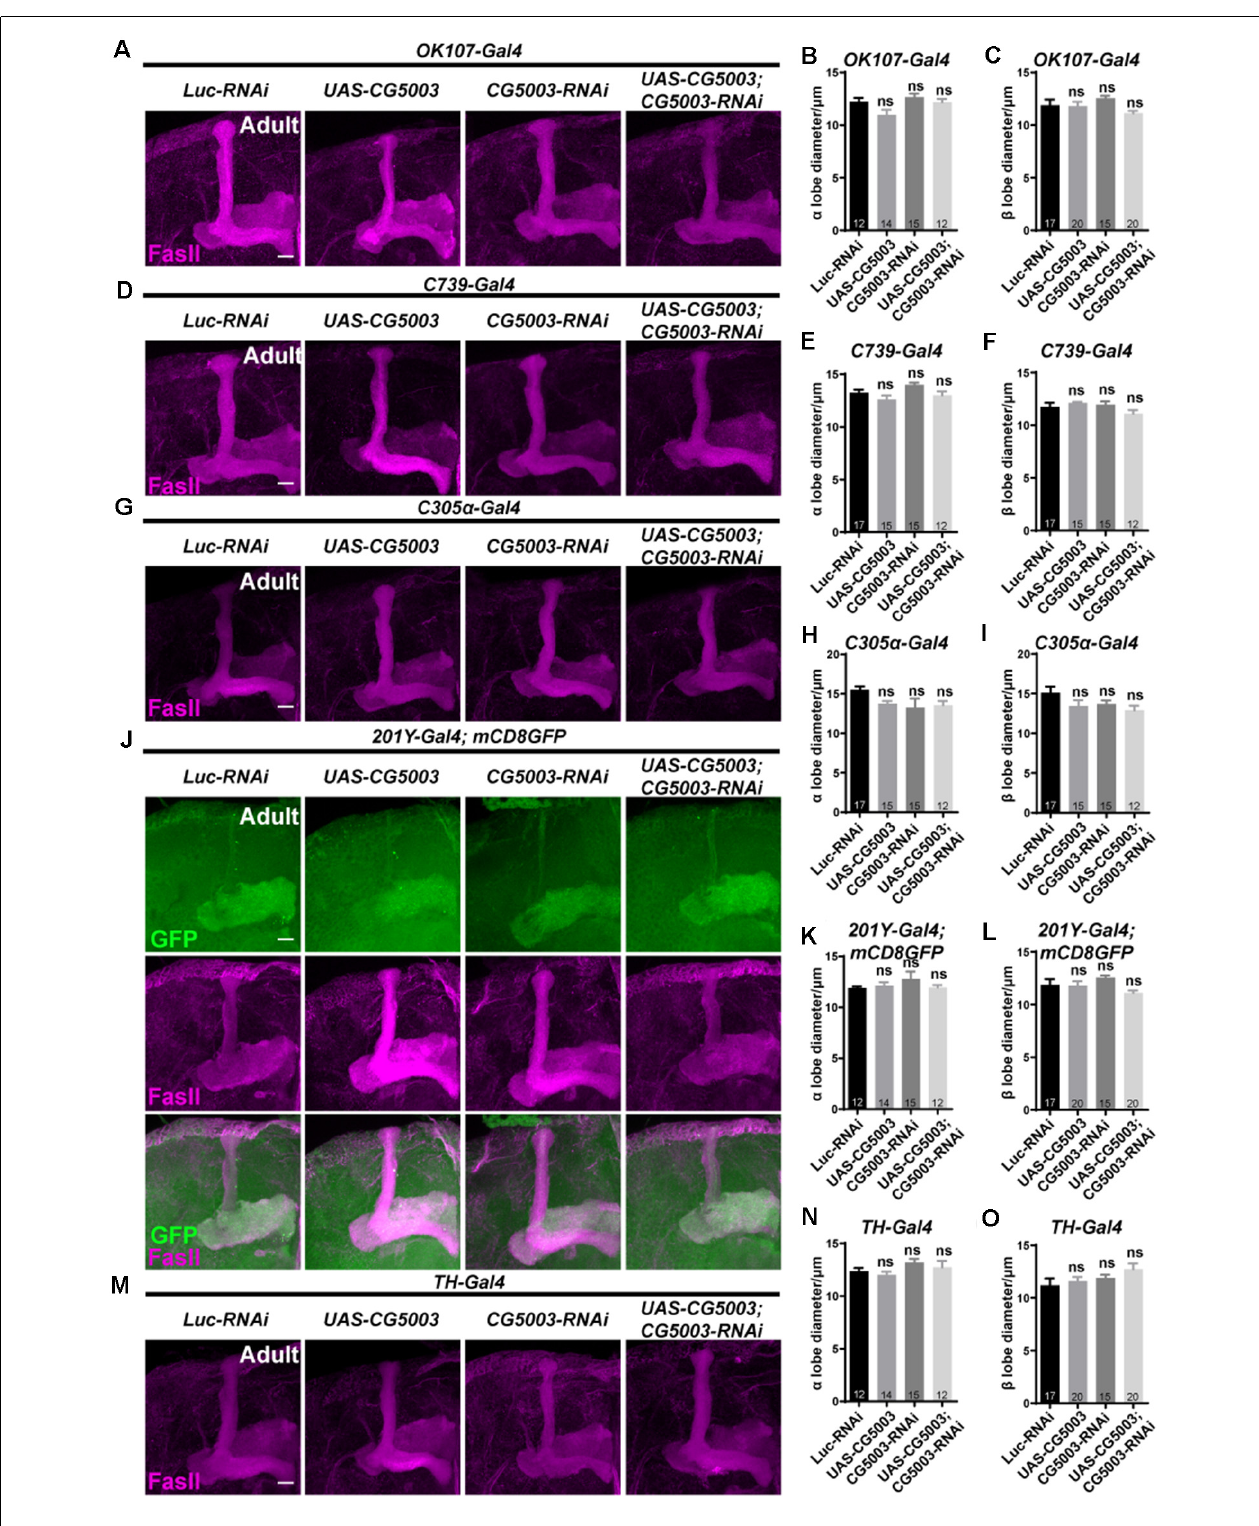
FIGURE 5 | α / β lobes remain normal when altering CG5003 expression in all or subsets of MB neurons. (A–O) Representative confocal images (A–M) and quantifications (B,C,E,F, H,I, K,L, N,O) of MB α / β lobe formation of control and experimental fly brains at the adult stage. Note that FasII-positive α / β lobes remain intact when CG5003 or CG5003-RNAi is expressed in all MB ( OK-107-Gal4 ), α / β ( C739-Gal4 ), α ’/ β ’ ( C305 α -Gal4 ), γ ( 201Y-Gal4 ), or DA ( TH-Gal4 ) neurons. The N number of brains dissected and quantified for each genotype is indicated in the figure. Scale bar: 50 µ m. ns, not significant.